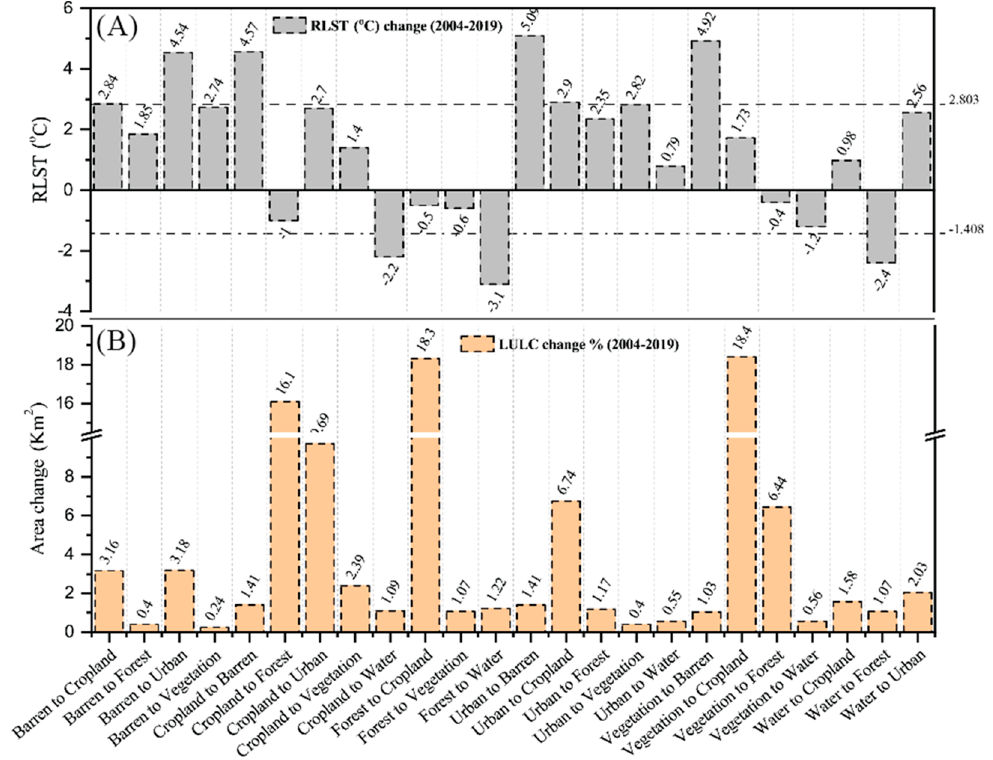
Figure 8. LUCC and RLST change from 1993 to 2018: ( A ) change in RLST °C and ( B ) change in % of LUCC area. Table 5. Statistics of the predicted LUCC area (km 2 ) for 2025 and 2050.